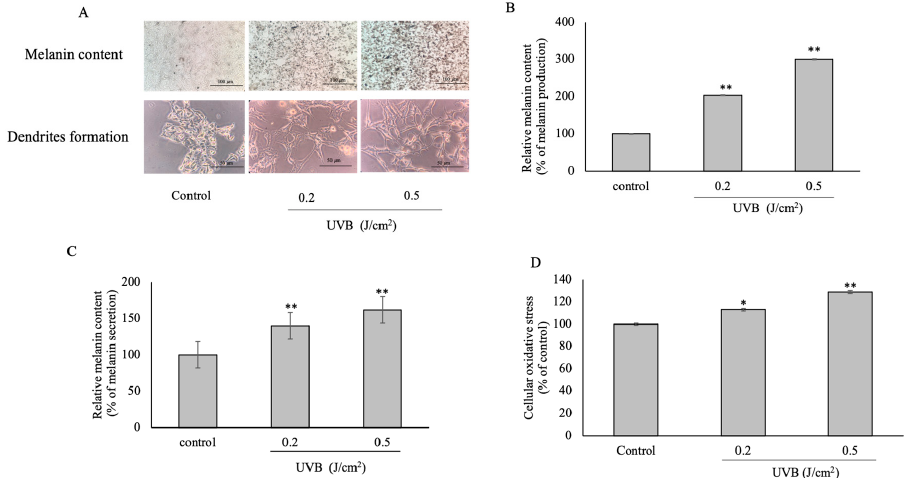
Figure 1. The effect of UVB on B16F10 cells at different concentrations (J/cm 2 ), Pictures of melanin content, and dendrite formation of UVB induced cells ( A ) The melanin production ( B ) and secretion ( C ) are related to melanin content and dendrite formation. Results were expressed in a bar graph as the percentage of melanin production and secretion. Cellular oxidative stress was present as a bar graph ( D ). The statistical significance of differences of each group was calculated by mean ± SD with the control (100%). *, ** Statistical significance at 𝑝 ≤ 0.05 and 𝑝 ≤ 0.001, respectively.